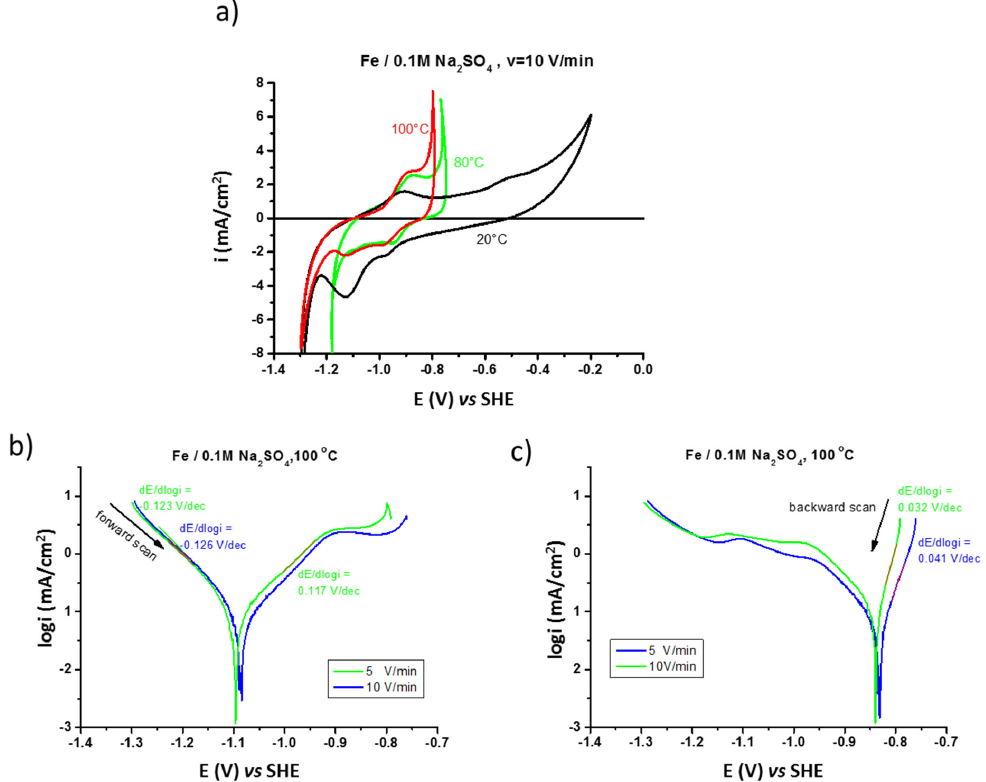
Figure 2. Influence of temperature on polarization (CV) of iron in 0.1 M Na 2 SO 4 saturated with argon performed at v =10 V/min ( a ) fast polarization ( v = 5 and 10 V/min) performed at 100 °C ( b ) forward, and ( c ) backward scans.